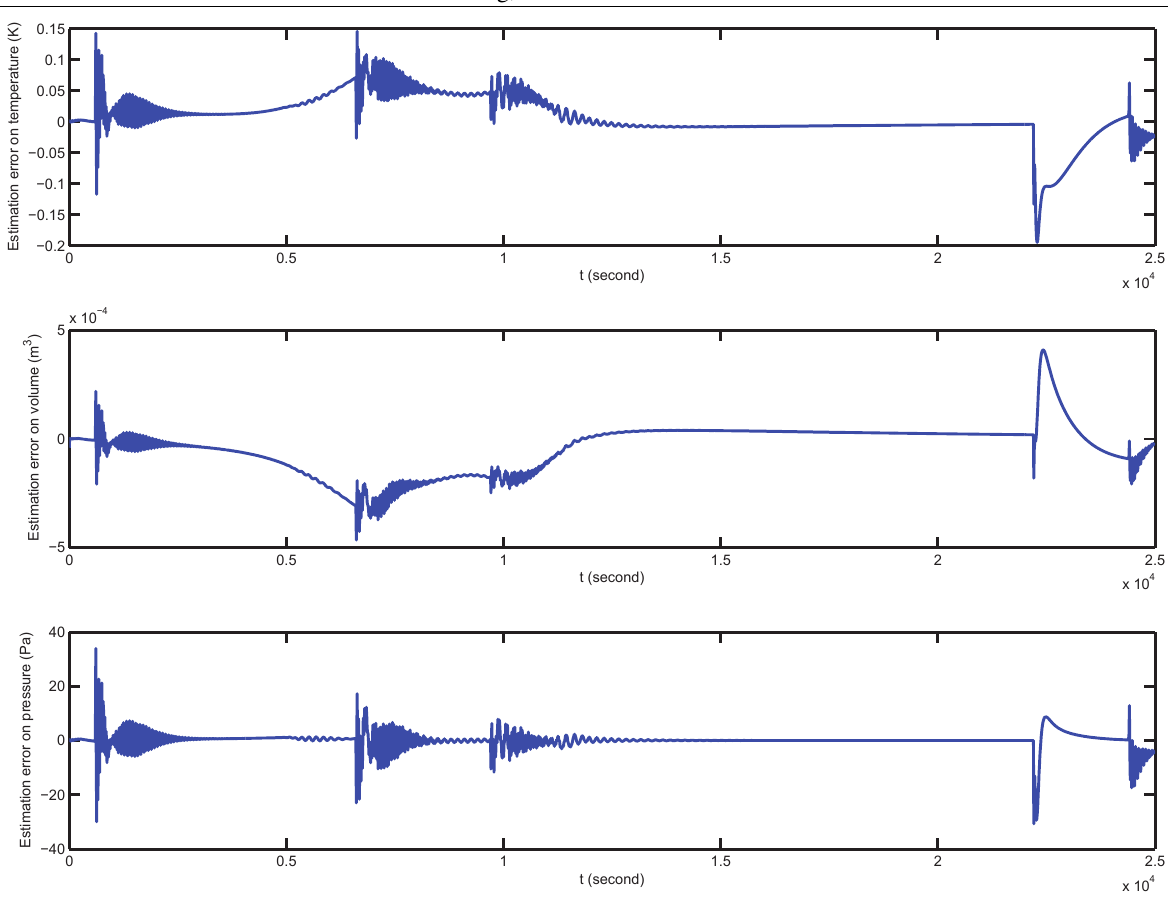
Figure 3: Estimation error of the